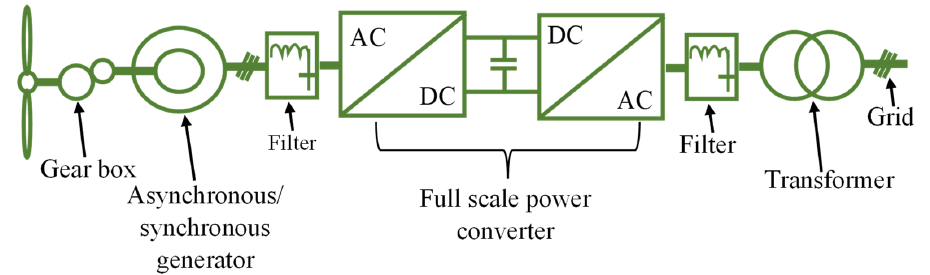
Figure 4. A typical SCIG-driven wind energy conversion system.